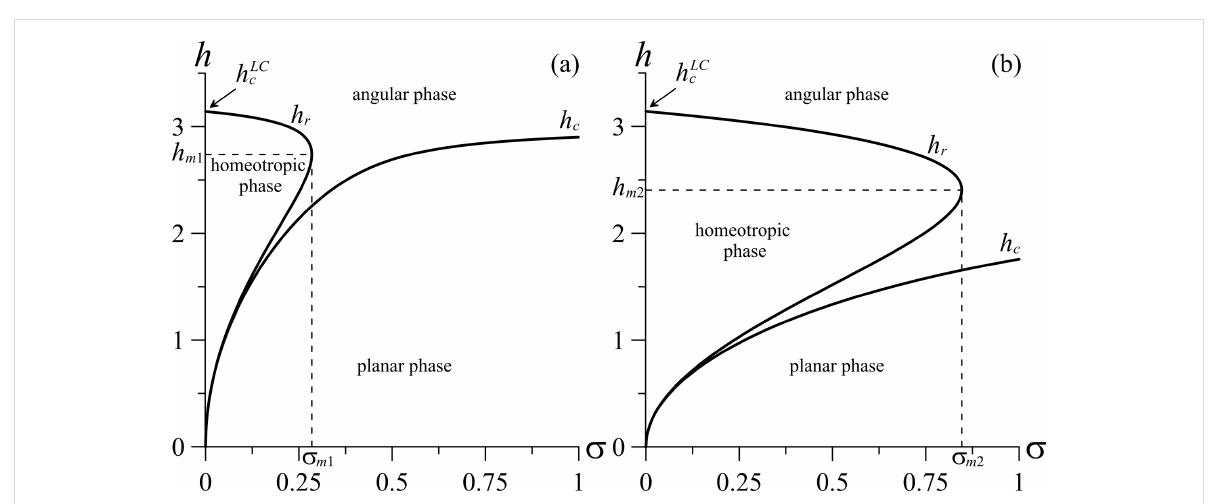
Figure 3: Diagram of the orientational state of the suspension for (a) γ = 0.1 [ σ m 1 = 0.285, h m 1 = 2.738] and (b) γ = 0.5 [ σ m 2 = 0.847, h m 2 =